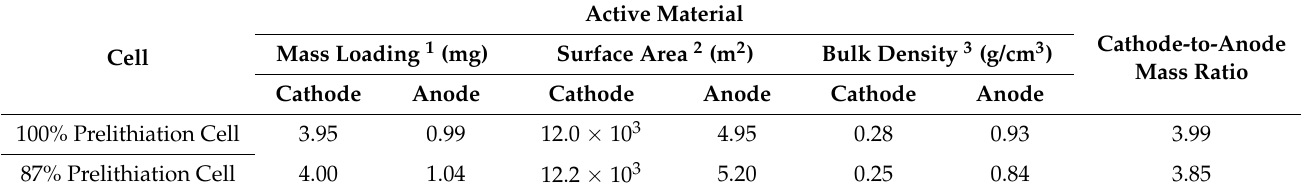
Table 1. Mass loadings, surface areas, and bulk densities of active materials for cathodes (AC) and anodes (Si) coated on current collectors ( ϕ 15 mm) and cathode-to-anode mass ratios for LIC